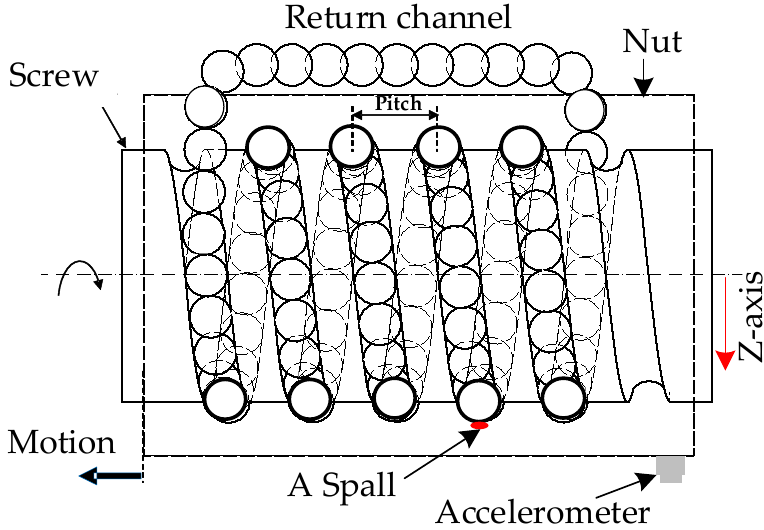
Figure 2. Illustration of a ball-screw mechanism within an EMA and the acceleration sensor mounted on the nut.